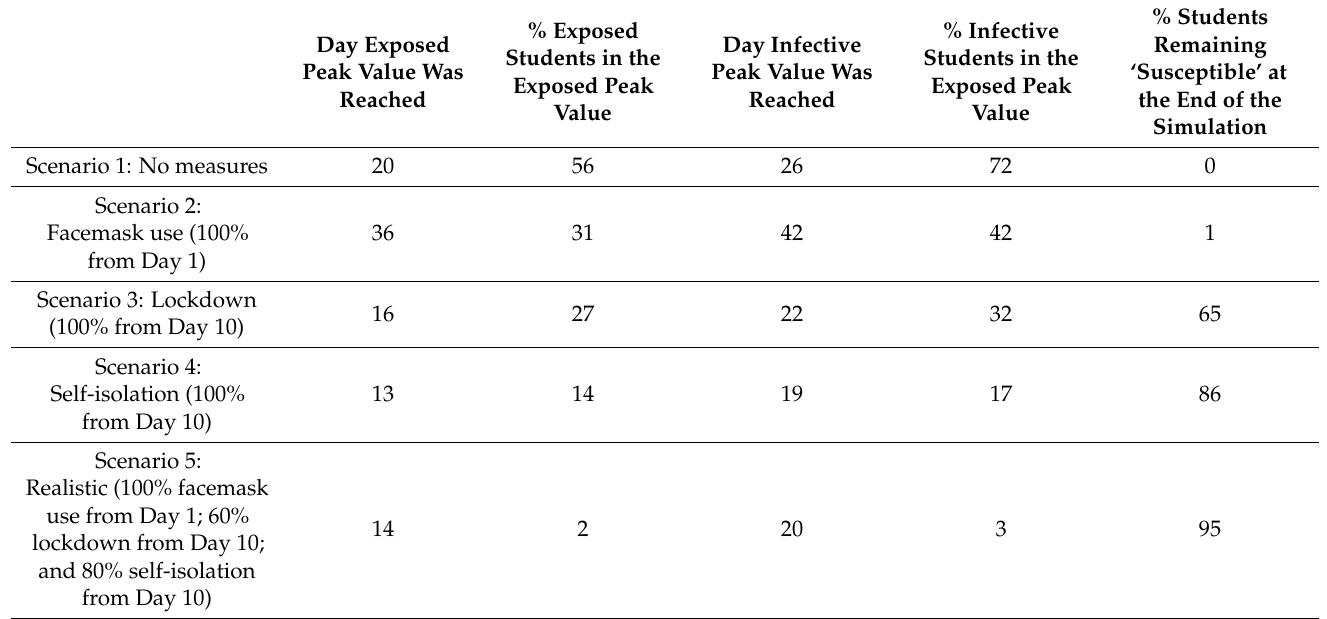
Table 9. Best obtained results from each of the case-scenarios